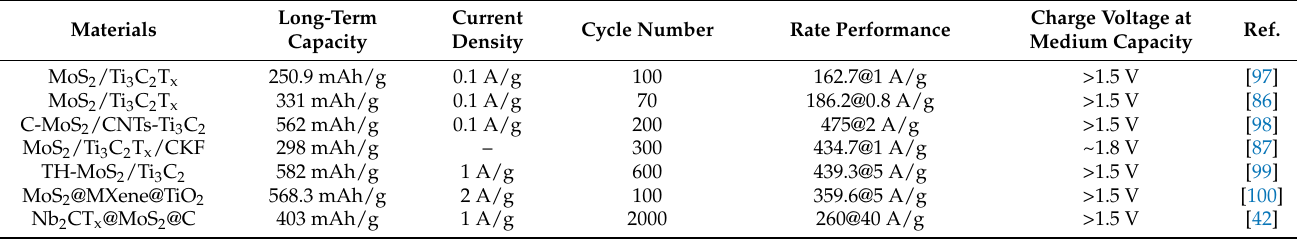
Table 4. Comparison of the performance values for different sulfide/MXene anodes in